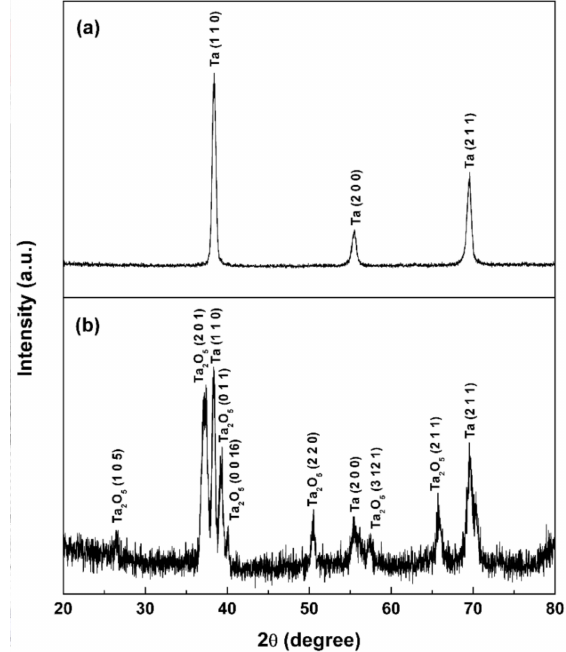
Figure 1. GIXRD profiles of the surface of as-sprayed tantalum (MT) coating ( a ) and surfaces obtained upon anodizing micro/nano tantalum (MNT) coating ( b